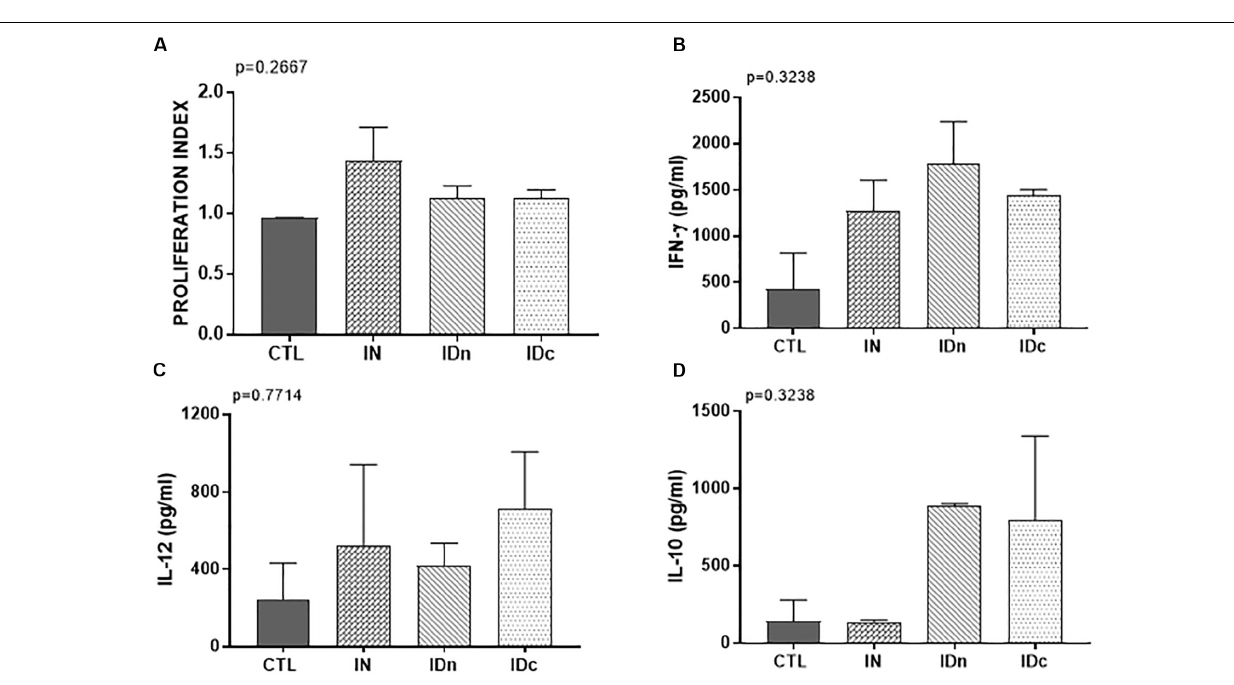
FIGURE 7 | Cellular immune response from spleen of two sheep 6 months after the last vaccination in the latent toxoplasmosis experiment. CTL: inoculated with DGNP alone as control; IN: vaccinated by nasal route; IDn: vaccinated by intradermal route in the neck area; and IDc: vaccinated by intradermal route in the